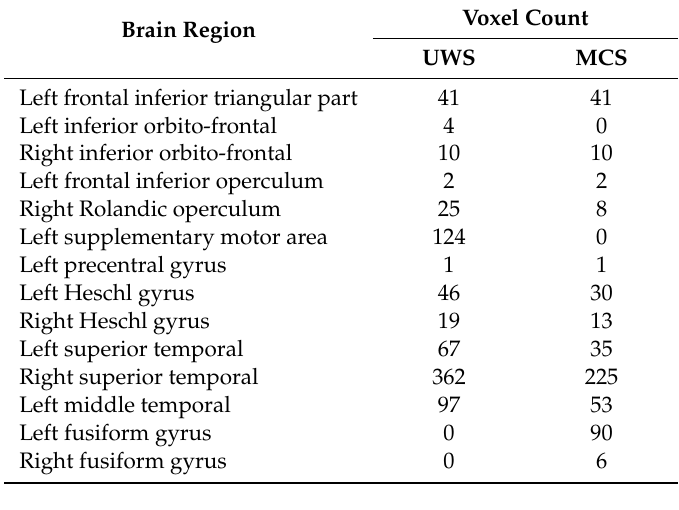
Table 6. Intersection results within the dorsal-attentional network. Brain areas of intersection (first column) and number of voxels in both unresponsive wakefulness syndrome patients (second column) and minimally conscious state patients (third column) obtained by means the voxel-count approach available in MRIcron [37].